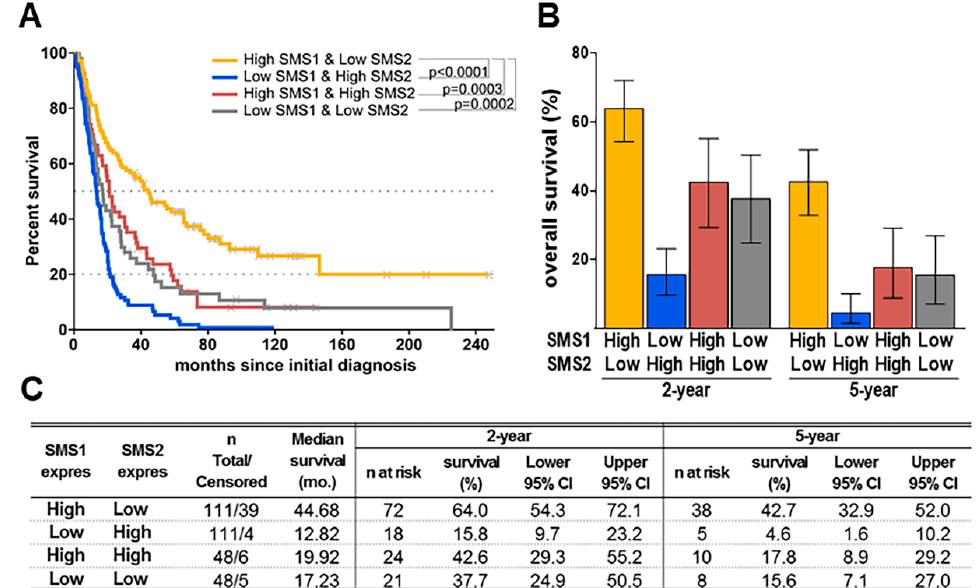
Figure 3. SMS1-to-SMS2 ratio relative to patient survival. ( A ) Kaplan-Meier plots representing glioma patient survival depending on SMS1 and SMS2 combined expressions. Patients’ biopsy samples were classified into four groups depending, firstly, on their SMS1 (considering high-expressing group when SMS1 expression was equal or higher than the median) and, secondly, on their SMS2 expression (SMS1 low and high groups were divided considering SMS2 expression median from all samples). ( B ) Overall-2-, and -5-year survivals after diagnostic in glioma patients (REMBRANDT database) classified according to their SMS1 and SMS2 combined expressions. Data are presented as Mean ± Error. ( C ) Patients at risk and median survival determined from glioma patients’ dataset as represented in ( A ); mo.: months; n: number of patients; CI: confidence interval.